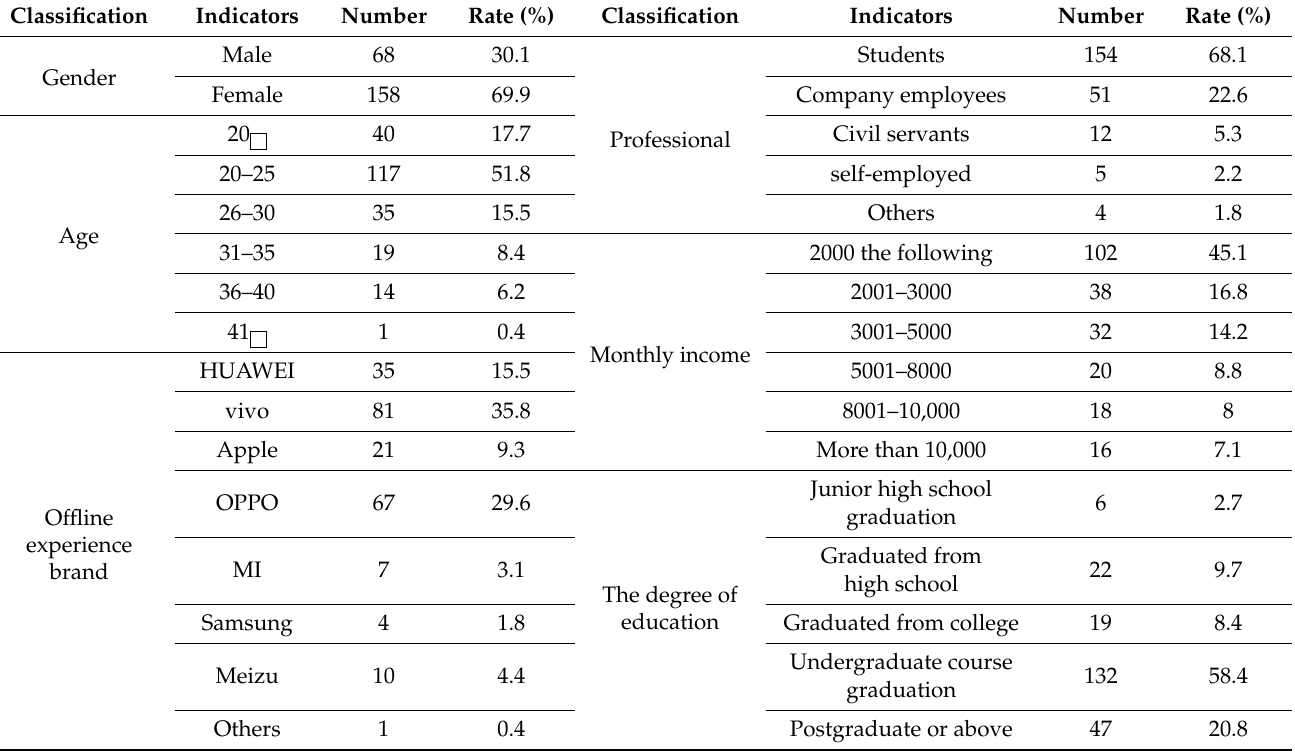
Table 1. Sample descriptive